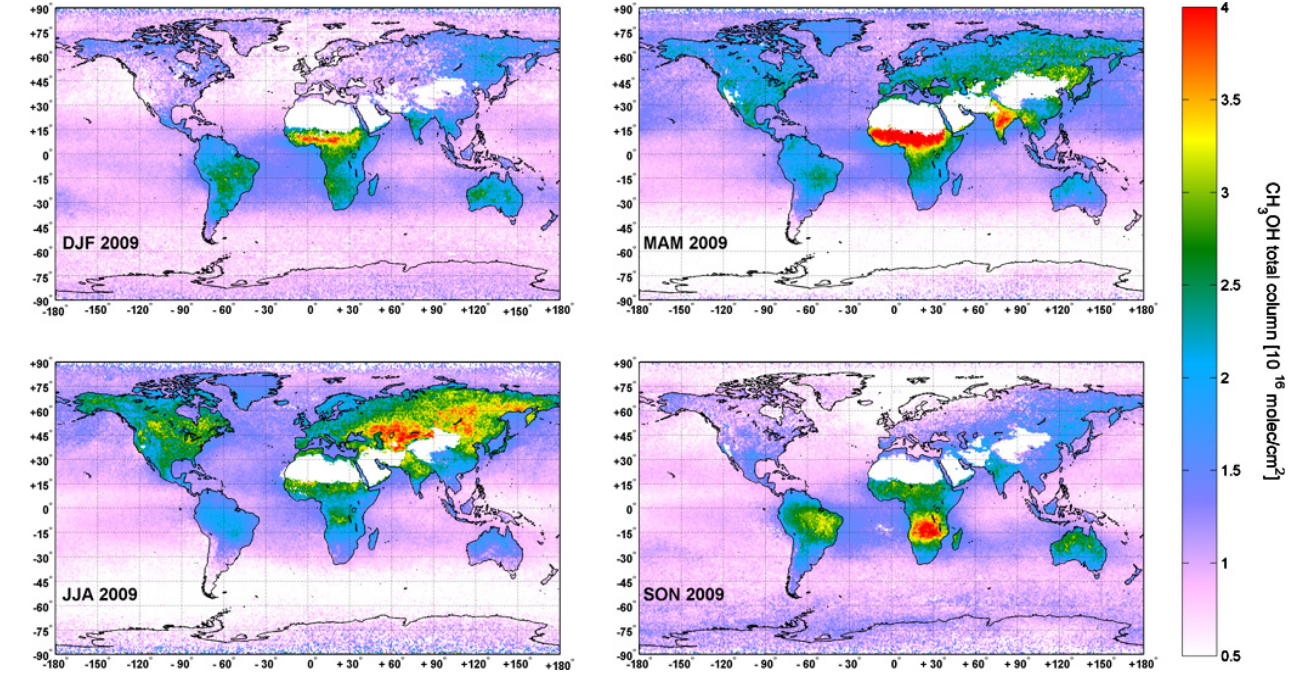
Fig. 6. Seasonal distributions of methanol total columns for the year 2009. The white areas correspond to a filter for sandy scenes where emissivity is